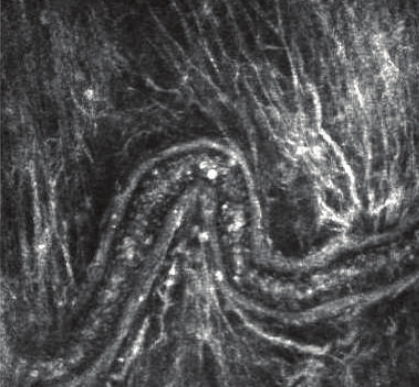
Figure 11: Enlarged aqueous vein after canaloplasty (Heidelberg Retina Tomograph cornea